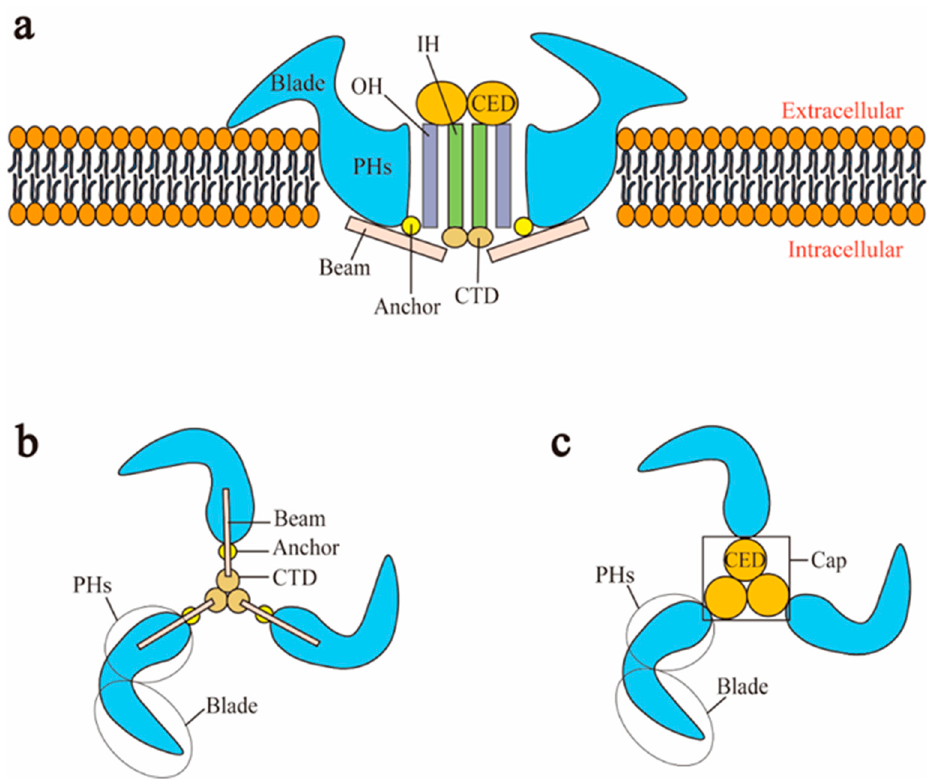
Figure 1. Schematic representation of Piezo1 channel. ( a ) Lateral view; ( b ) bottom view; ( c ) top view. CED: C-terminal extracellular domain; CTD: intracellular C-terminal domain; IH: inner helix; OH: outer helix; PHs: peripheral helices.